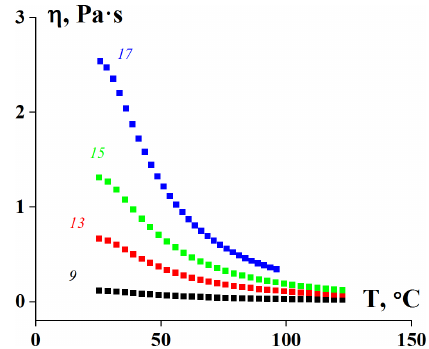
Figure 4: Temperature dependencies of the viscosity of PSu solu- tions of different concentrations in linear coordinates. Figures at the curves show the concentration of the polymer in vol.%.